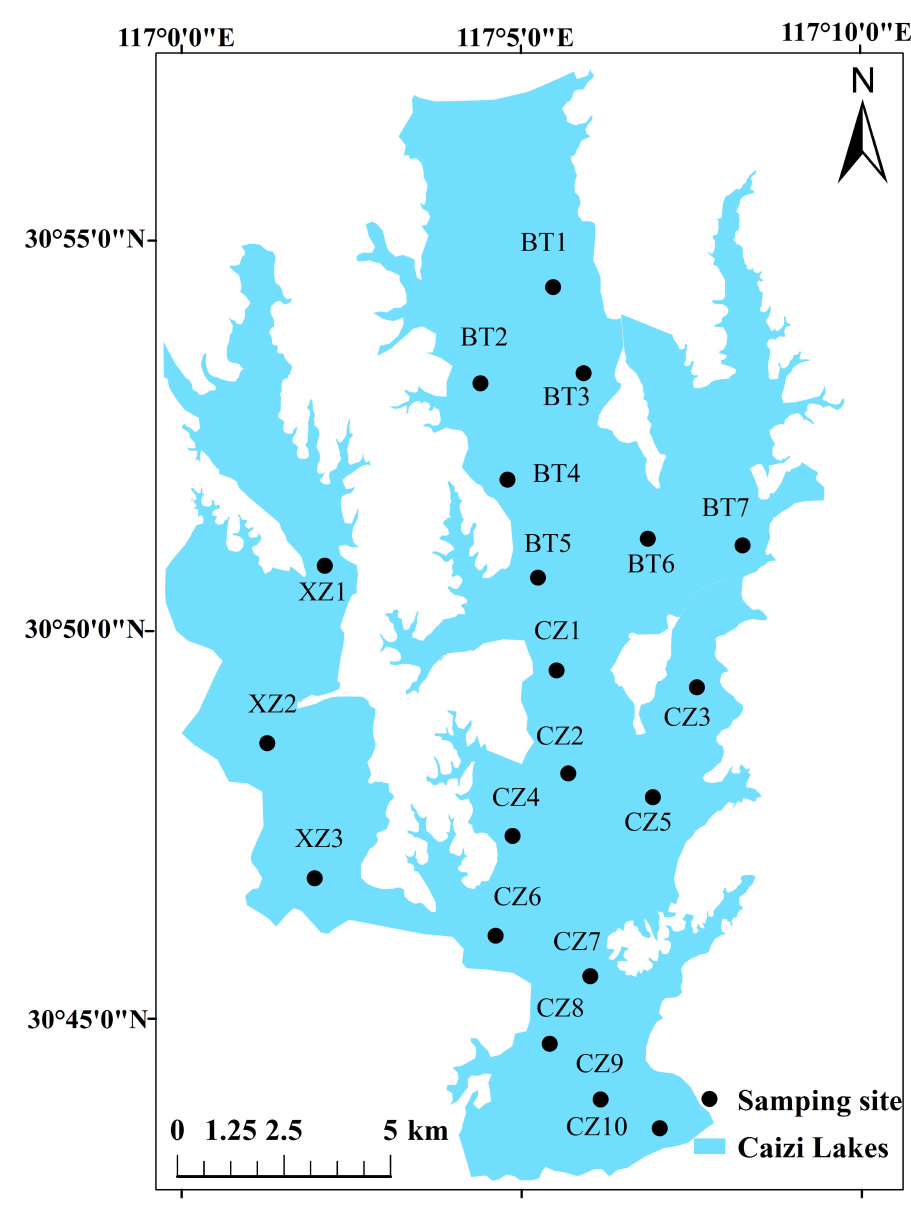
Figure 1. Distribution of sampling points in Caizi Lakes (BT to Baitu, CZ to Caizi, and XZ to